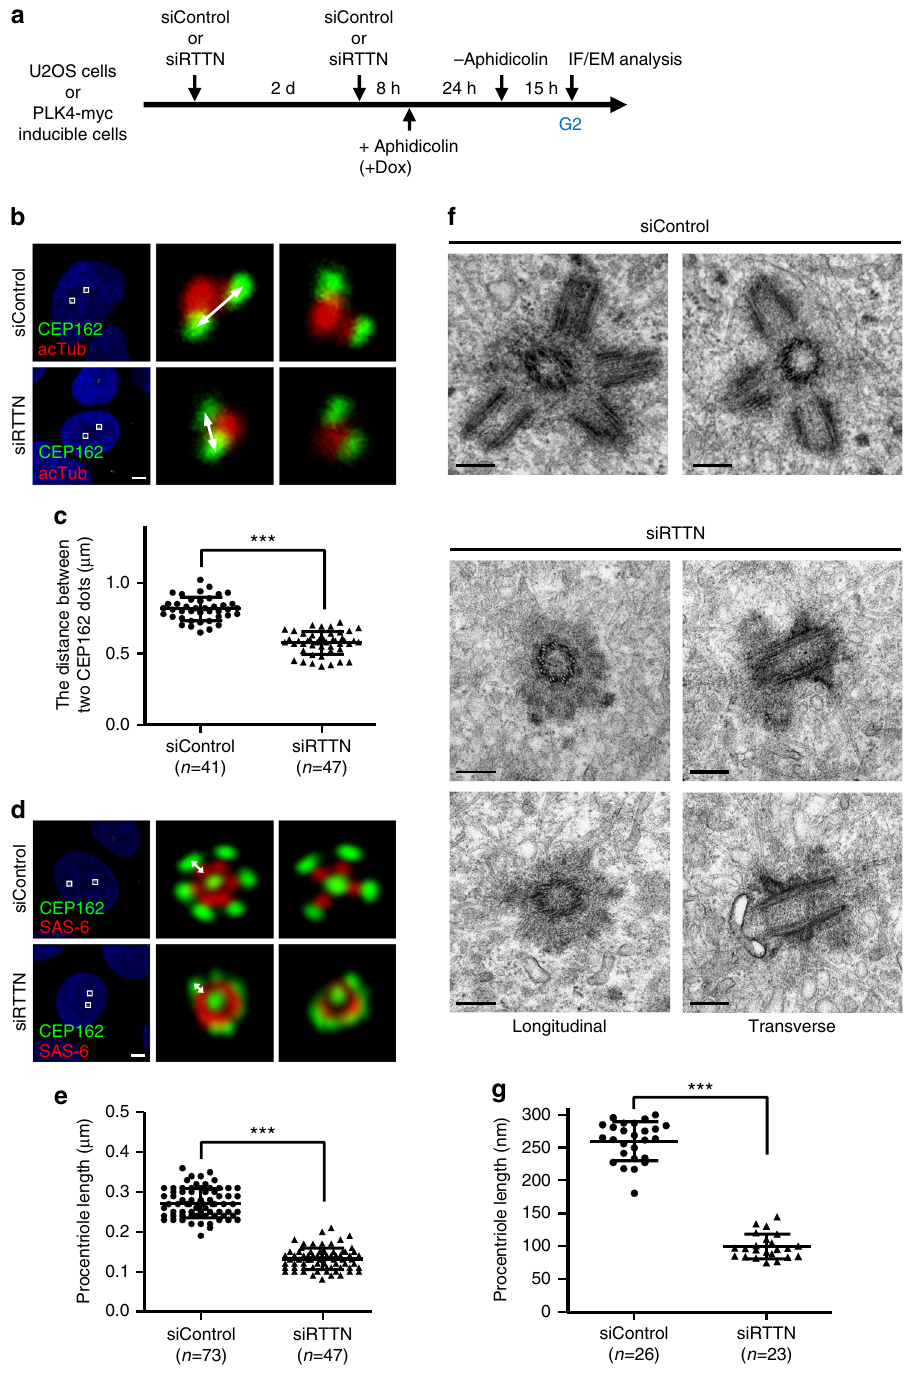
Fig. 3 Depletion of RTTN produces shorter centrioles. a , b U2OS cells were treated with siControl or siRTTN as shown in a , and analyzed by confocal fl uorescence microscopy using the indicated antibodies. c Histogram illustrating the distance between the CEP162-positive dots associated with a given pair of orthogonally oriented centrioles. Error bars represent the mean ± s.d.; *** P < 0.001 (two-tailed t -test). d , f PLK4-myc doxycycline (Dox) inducible cells were treated with siControl or siRTTN as shown in a , and then analyzed by confocal fl uorescence microscopy using the indicated antibodies d , or by electron microscopy f . e , g Histogram illustrating the length of procentrioles in PLK4-myc-inducible cells, as analyzed by confocal microscopy e or electron microscopy g . Error bars represent the mean ± s.d.; *** P < 0.001 (two-tailed t -test). The procentriole length in b/c was measured as the distance between two CEP162 dots as described by Azimzadeh et al. 17 The procentriole length in d/e was measured as the distance between the fl uorescent peak intensity of SAS-6 ( red ) and CEP162 ( green ) in siControl and siRTTN-treated cells. Scale bar , 5 μ m in b and d ; Scale bar , 200 nm in